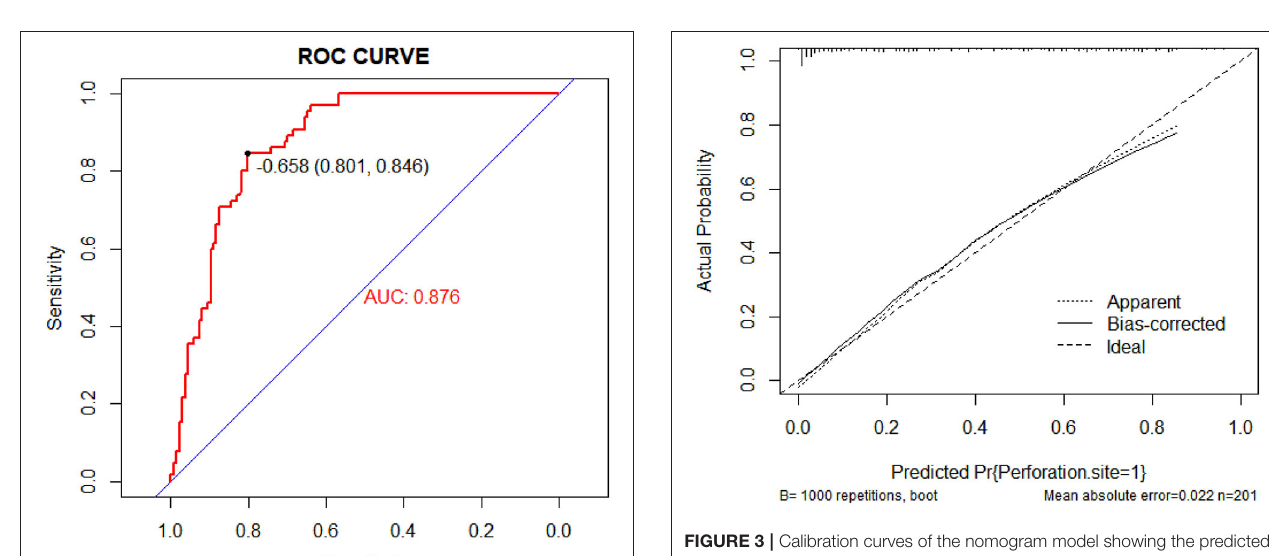
the training cohort ( Figure 3 ). The Hosmer-Lemeshow test yielded a P -value of 0.8977, indicating that the model was